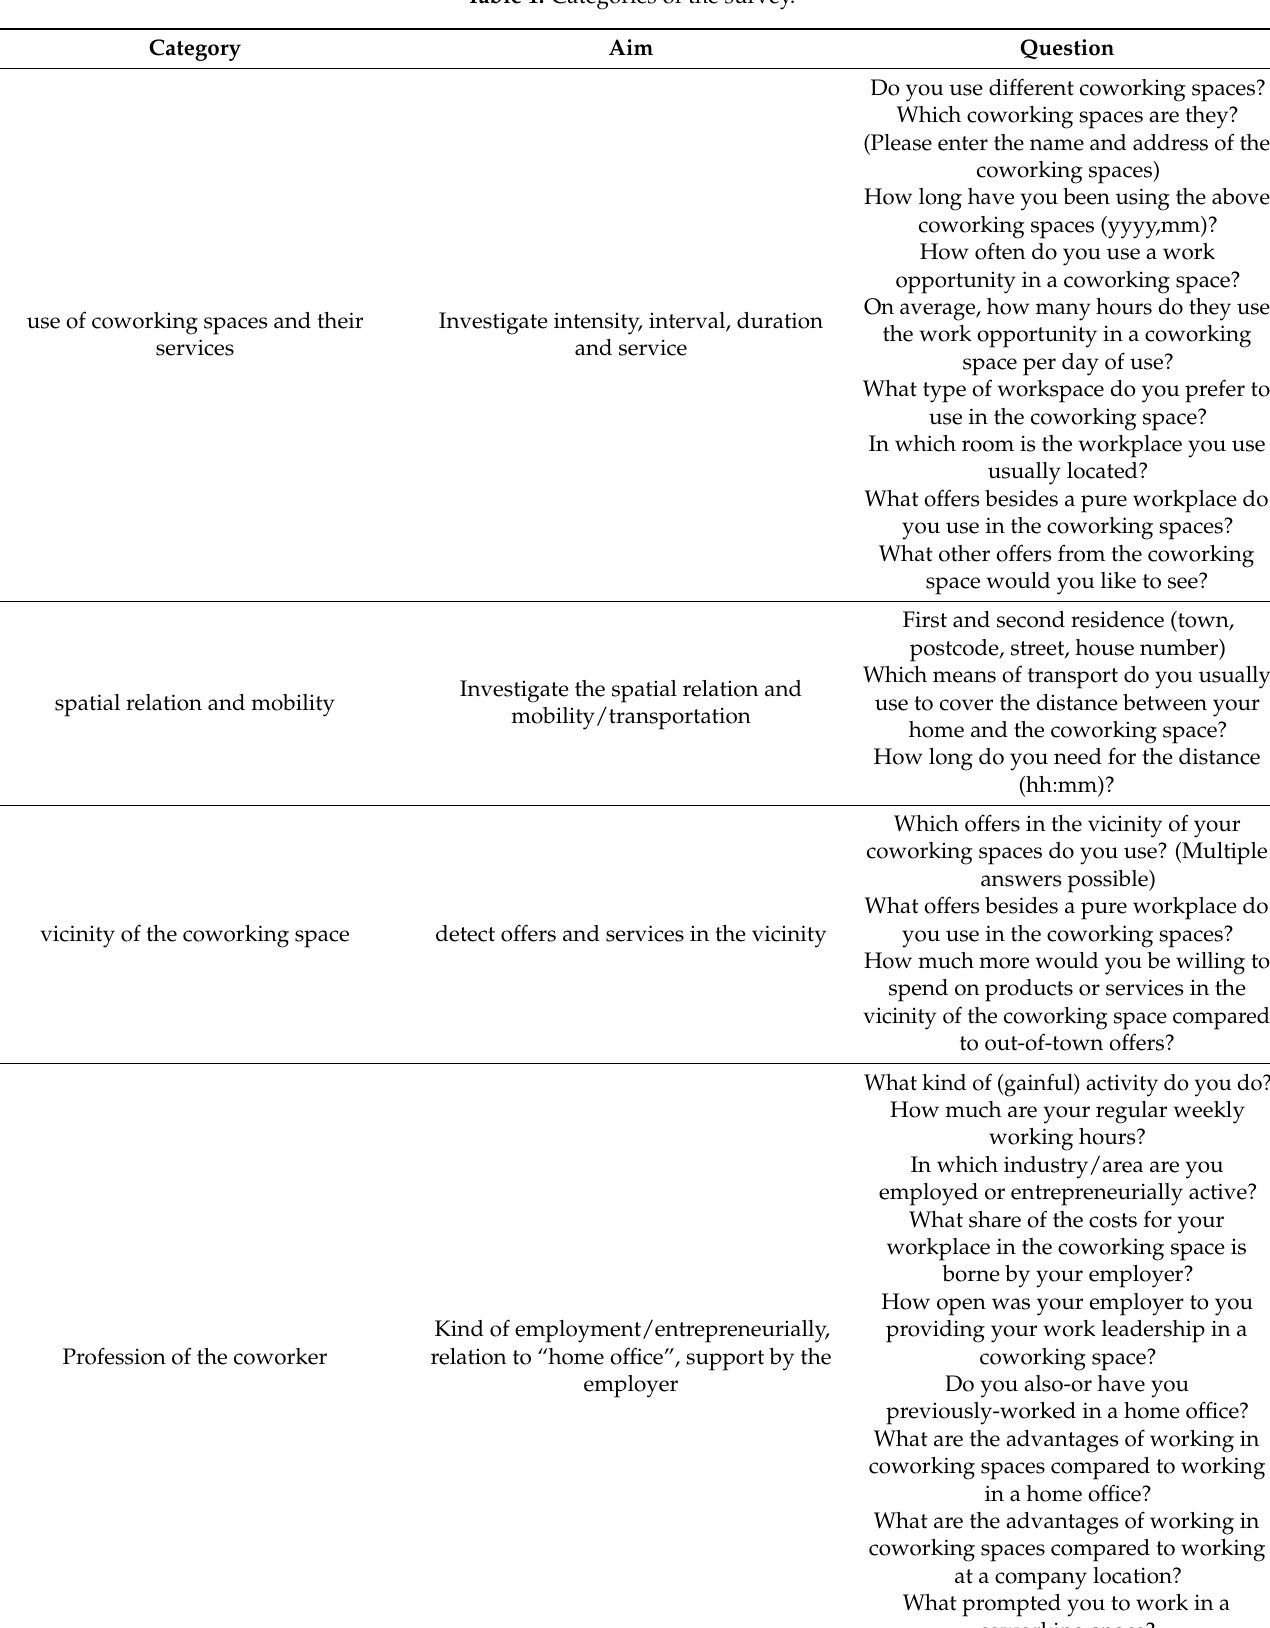
Table 1. Categories of the